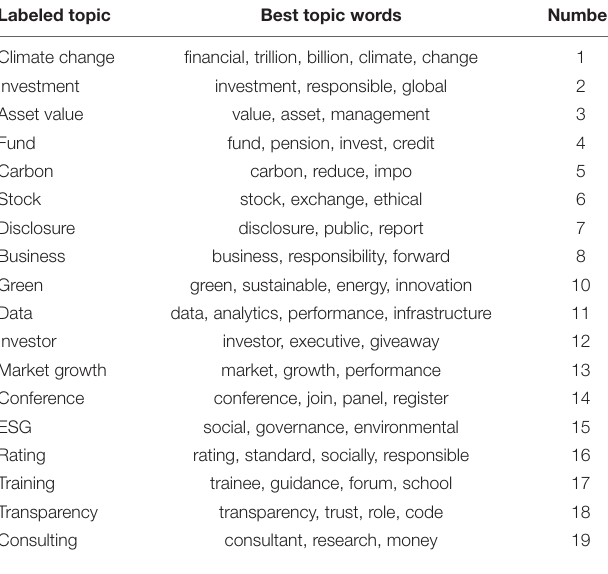
TABLE 2 | Labeled topics and its top